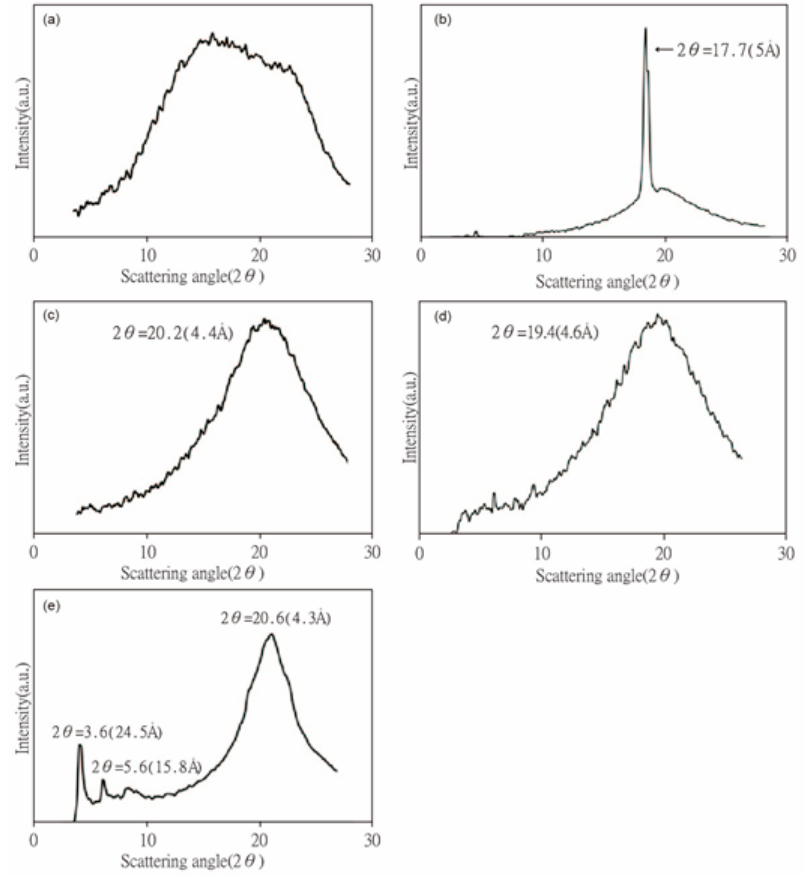
Figure 4. XRD of Thermosets of TMBPE ( a ), BPE ( b ), SBPDAE ( c ), SBBDAE ( d ) and SBODAE ( e ).